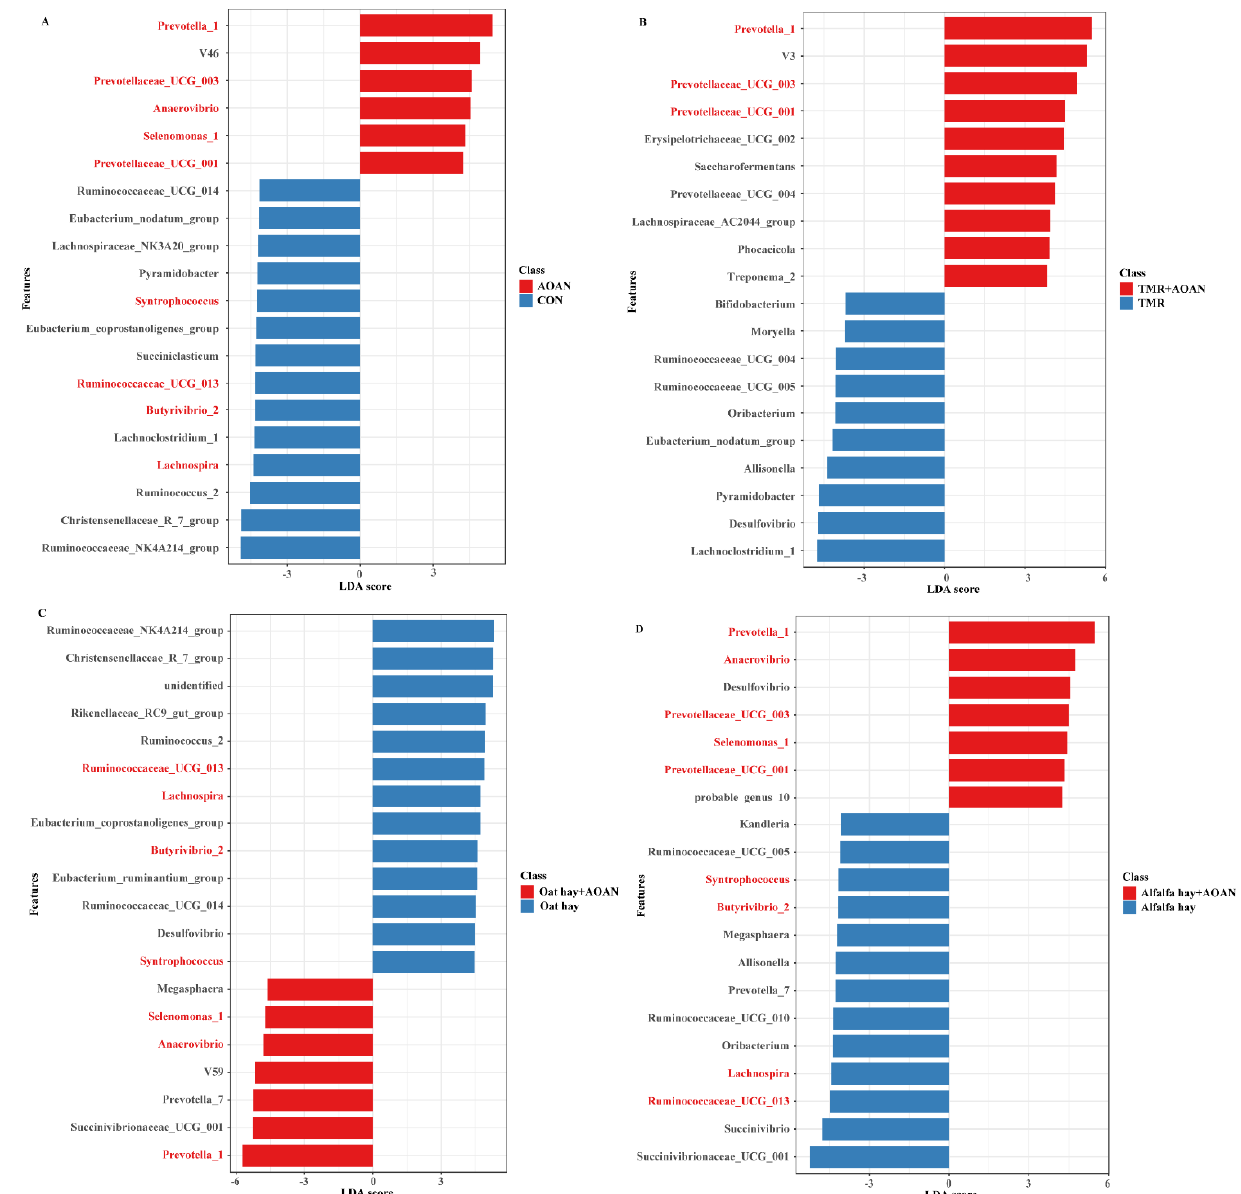
Figure 8. Differential bacterial genera between CON (all feeds without AOAN supplementation) and AOAN (all feeds with AOAN supplementation) ( A ), TMR and TMR + AOAN ( B ), oat hay and oat hay + AOAN ( C ), alfalfa hay and alfalfa hay + AOAN ( D ). AOAN indicated feed fermentation with Aspergillus oryzae and Aspergillus niger co-cultivation fermentation extract. CON group indicates all feeds without AOAN supplementation. AOAN group indicates all feeds with AOAN supplementation. Significant differences were tested by linear discriminant analysis effect size (LEfSe) and declared as |linear discriminant analysis score| > 2 and adjusted- p < 0.10. The genera in red indicate that the genus was enriched more than three times. TMR, total mixed ration.